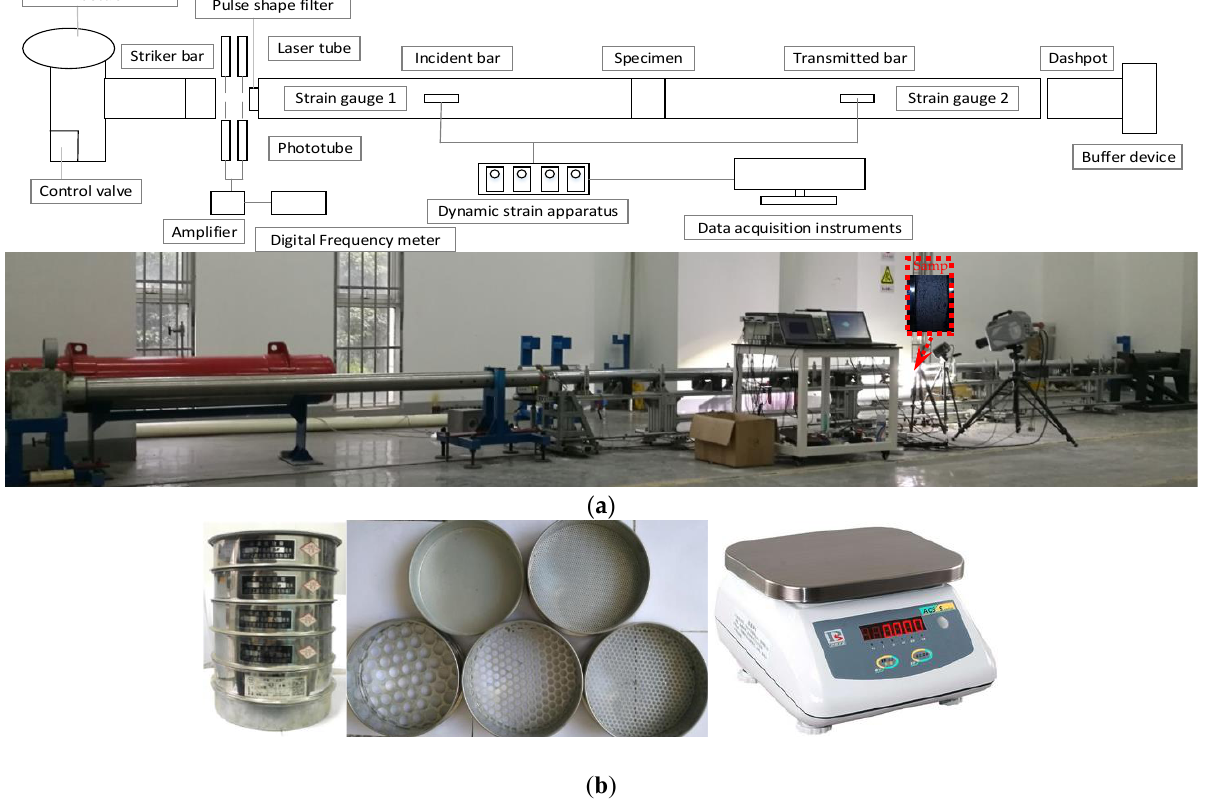
Figure 2. Test equipment. ( a ) SHPB apparatus system. ( b ) Screening device.